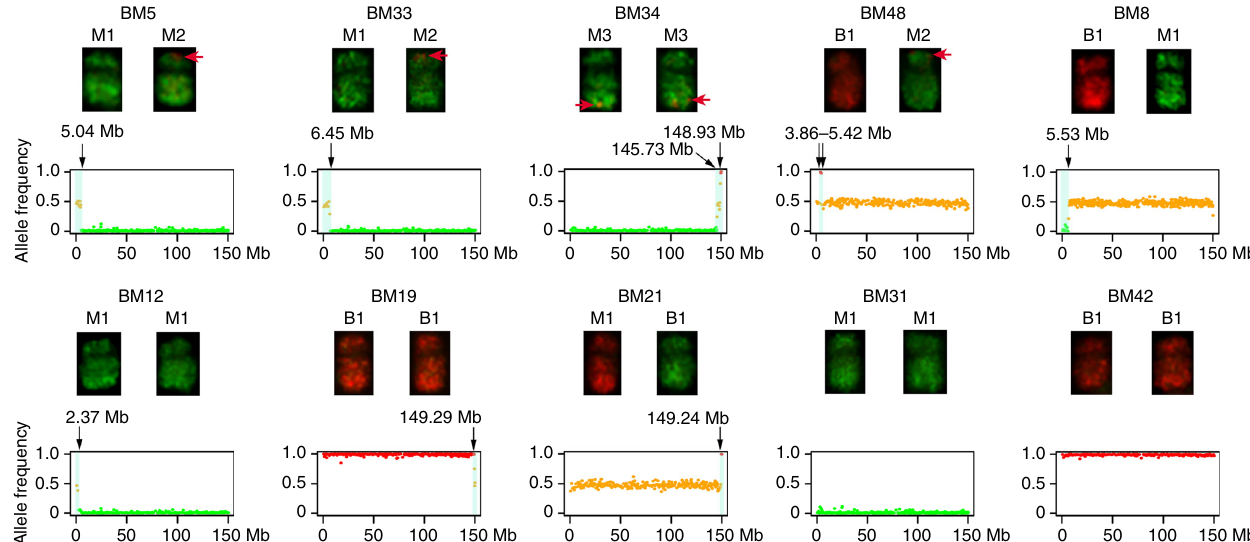
Fig. 5 Oligo-FISH and sequencing analyses of 10 F 2 plants. Red arrows indicate the B73 FISH signals located on Mo17-derived chromosome 10 in BM5, BM33, BM34, and BM48. These crossovers (COs) were inconsistently detected in different metaphase cells in each line. Black arrows mark the chromosomal exchange position on chromosome 10. No CO was detected in any of the chromosome 10 in BM31 and BM42. The y -axis of each sequencing pro fi le represents the allele frequency of B73 (red) or Mo17 (green). The x -axis represents the sequence position of chromosome 10 (150.98 Mb). Orange dots indicate the mix of red (B73 allele) and green (Mo17 allele) dots